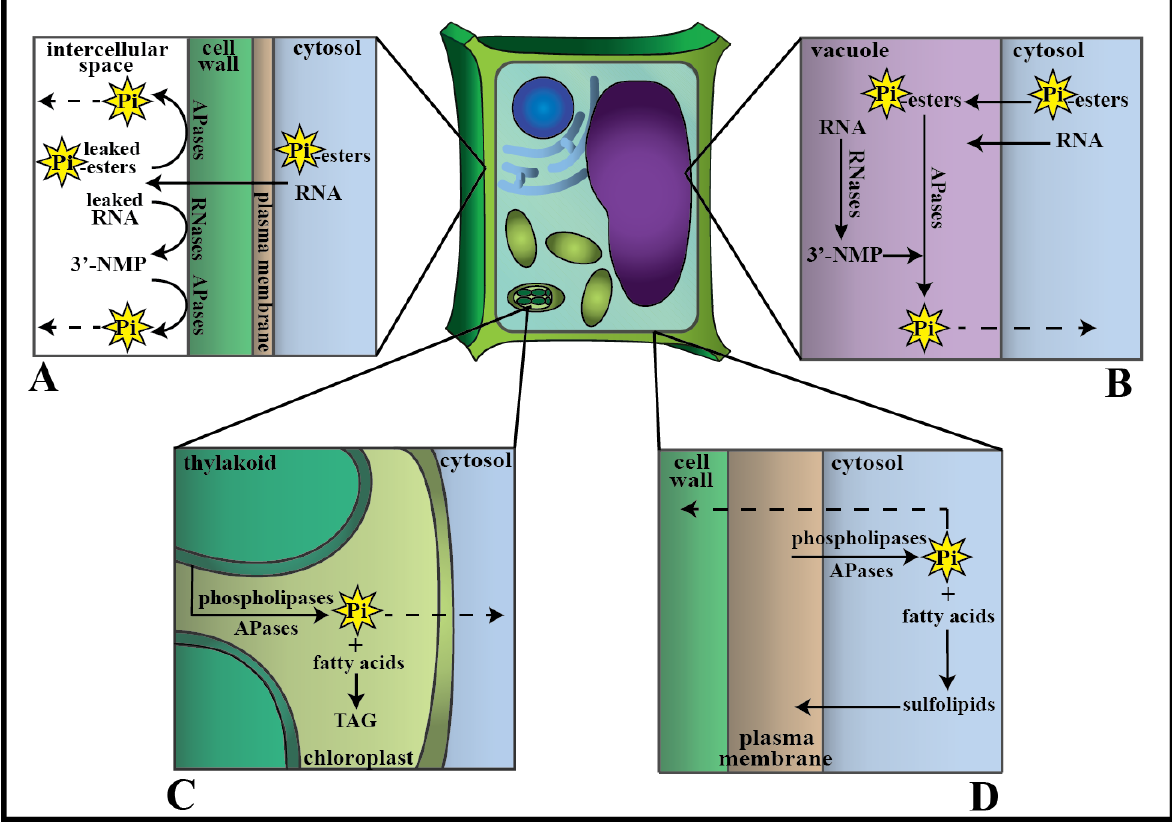
Figure 4. Simplified model of Pi remobilization in a senescing plant cell. ( A ) RNA oligonucleotides and Pi-esters leak through the partially degraded plasma membrane beyond the cell wall, where they are respectively hydrolyzed by cell wall-localized RNases and acid phosphatases (APases). Dotted lines denote the transport of Pi out of the senescing cell to other tissues. ( B ) Intracellular RNases and APases hydrolyze RNA and Pi-esters, respectively, in the vacuole. ( C ) Phospholipids are metabolized by the action of phospholipases and APases in the chloroplasts; Pi is released and free fatty acids are sequestered as triacylglycerol (TAG). ( D ) Phospholipases and APases liberate Pi from phospholipids of the plasma membrane, with some of the resulting free fatty acids being incorporated back into the membrane as